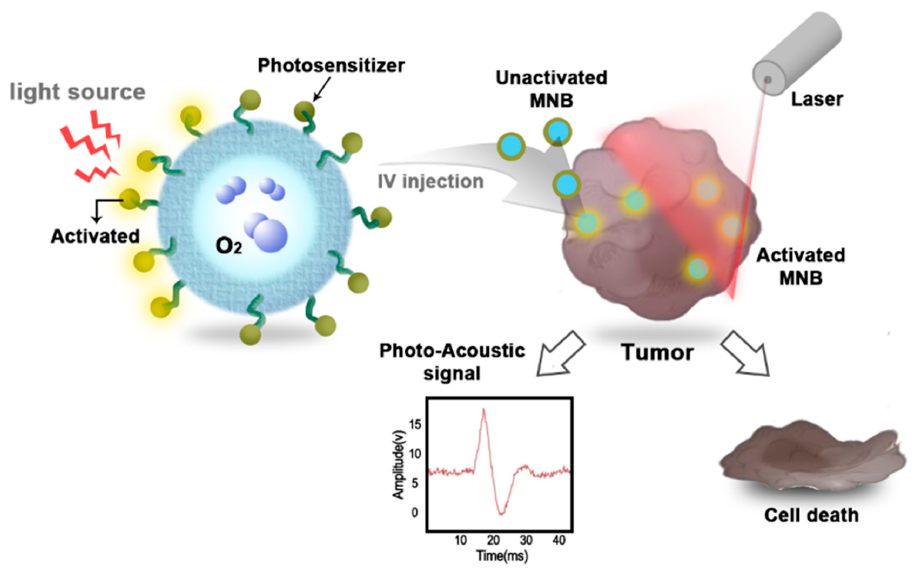
Figure 3. Potential of oxygen-containing MNBs for photoacoustic imaging and photodynamic therapy.